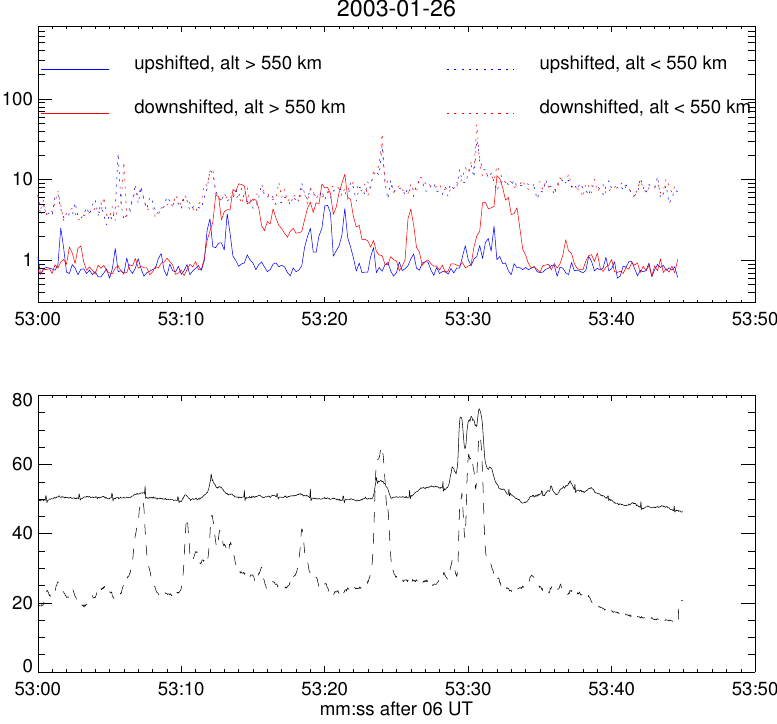
Fig. 3. Time series of radar (upper panel) and imager (lower panel) data from event 4. The radar data is power per unit frequency at the peak of the ion-acoustic shoulder, for two different height regions and for the up- and down-shifted shoulder, as a function of time (arbitrary units). In the lower panel the total “in-beam” luminosity, measured by the imager (arbitrary units), is shown as a function of time. This event was covered by two imagers, and the dashed line in the lower panel shows the in-beam luminosity moves from the SIF imager mounted at the Auroral Station, while the solid line is from the Odin imager mounted at the ESR site. The view from the ESR was slightly obscured by thin cloud, and the periodic spikes in the solid line are due to reflections from this layer of a warning